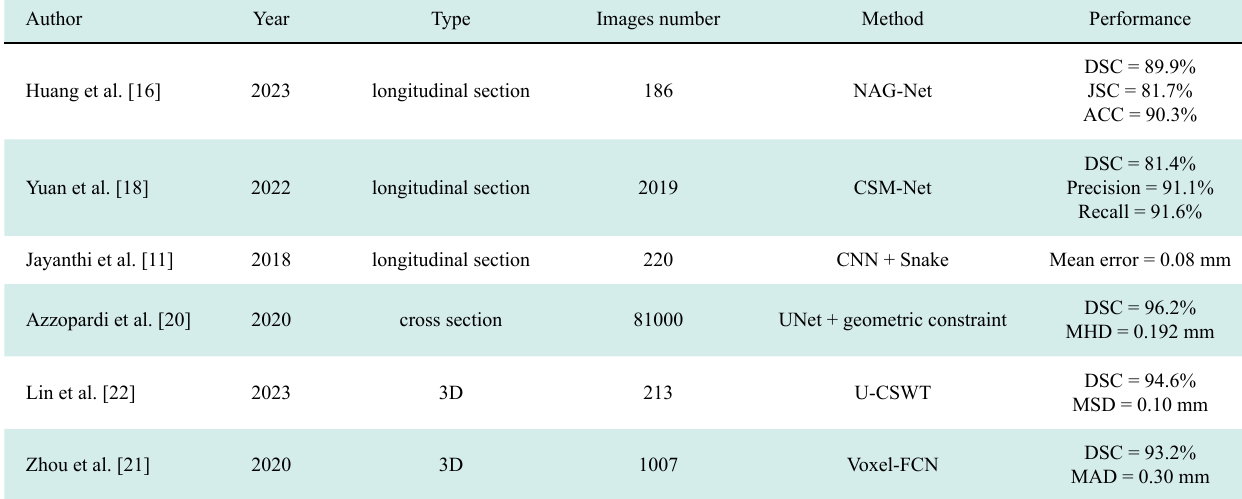
Table 1 Comparison between the IMC segmentation methods in different